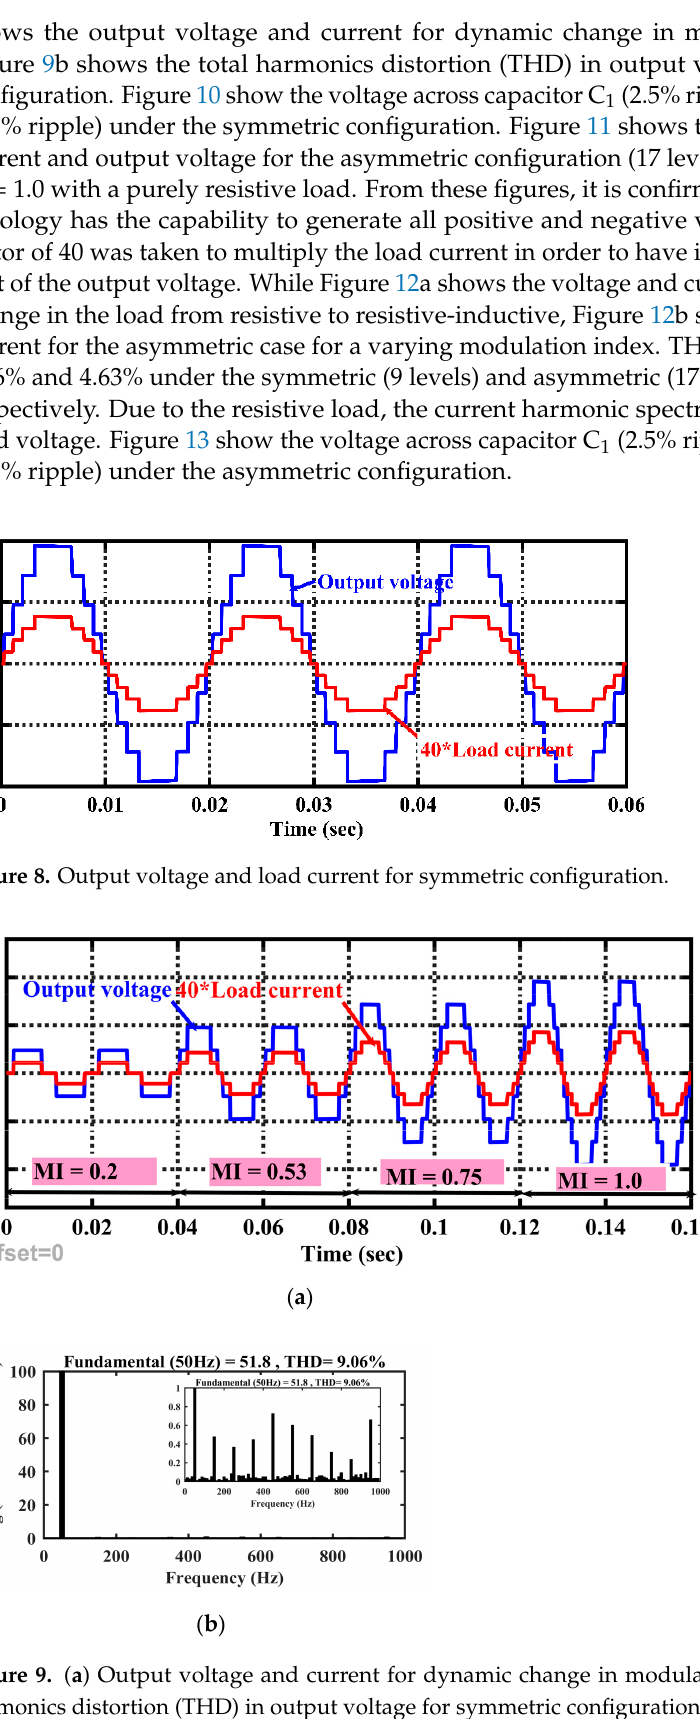
Figure 10. Voltage across capacitors C 1 and C 2 for symmetric configuration. Figure 11. Output voltage and load current for asymmetric configuration.